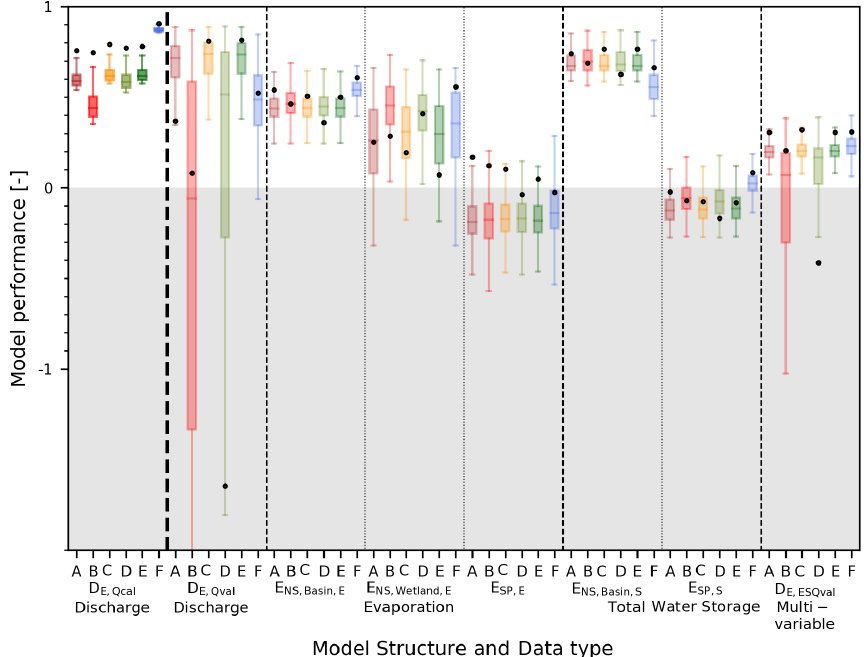
Figure 3. Model performance with respect to discharge, evaporation and storage for all models. The model is calibrated to dis- charge ( D E ,Q cal , darker boxplots in the first column) and validated to the discharge, evaporation and storage (lighter boxplots). The dots represent the model performance using the “optimal” parameter set and the boxplot the range of the best 5% solutions, both according to discharge ( D E ,Q cal ). The following performance metrics were used: (1) discharge using the overall model performance metric ( D E ,Q cal for calibration and D E ,Q val for validation), (2) temporal evaporation basin-average ( E NS , Basin , E ), (3) temporal evaporation, wetland areas only ( E NS , Wetland , E ), (4) spatial evaporation ( E SP , E ), (5) temporal storage basin-average ( E NS , Basin , S ), (6) spatial storage ( E SP , S ) and (7) the combination of evaporation, storage and discharge (combined metric D E , ES Q val ).